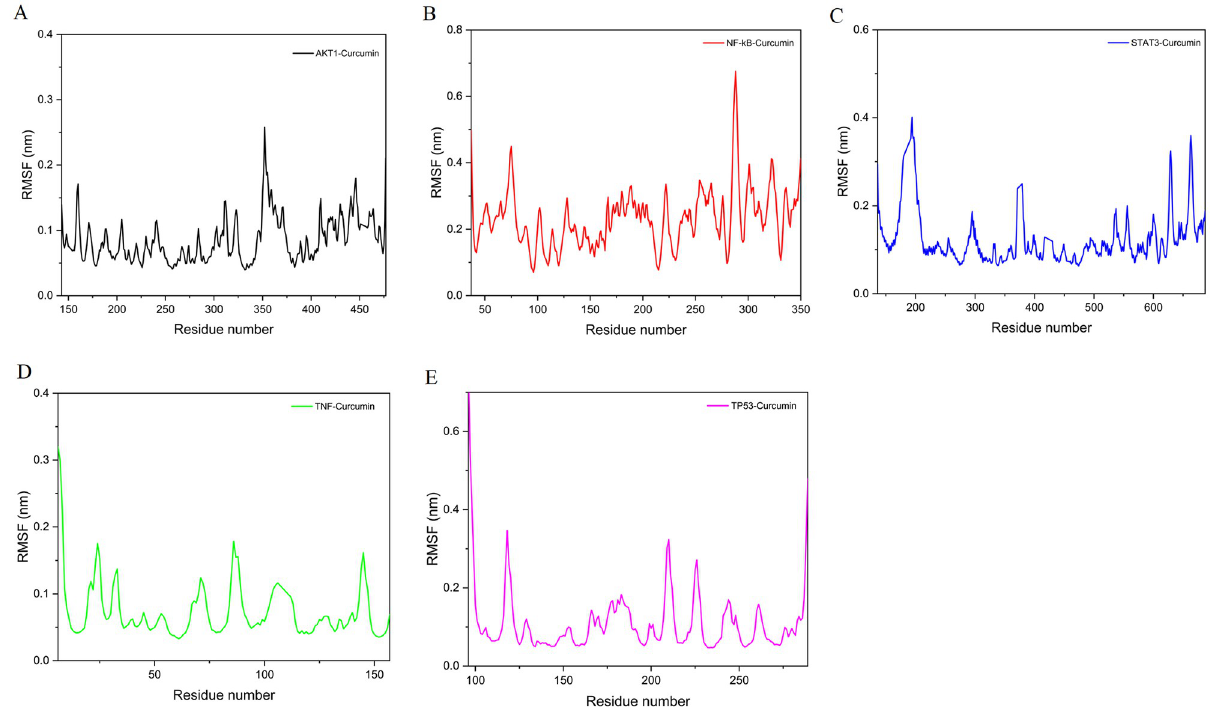
Fig 8. RMSF of the complex. (A) AKT1–curcumin. (B) NF- κ B–curcumin. (C) STAT3–curcumin. (D) TNF–curcumin. (E) TP53–curcumin.